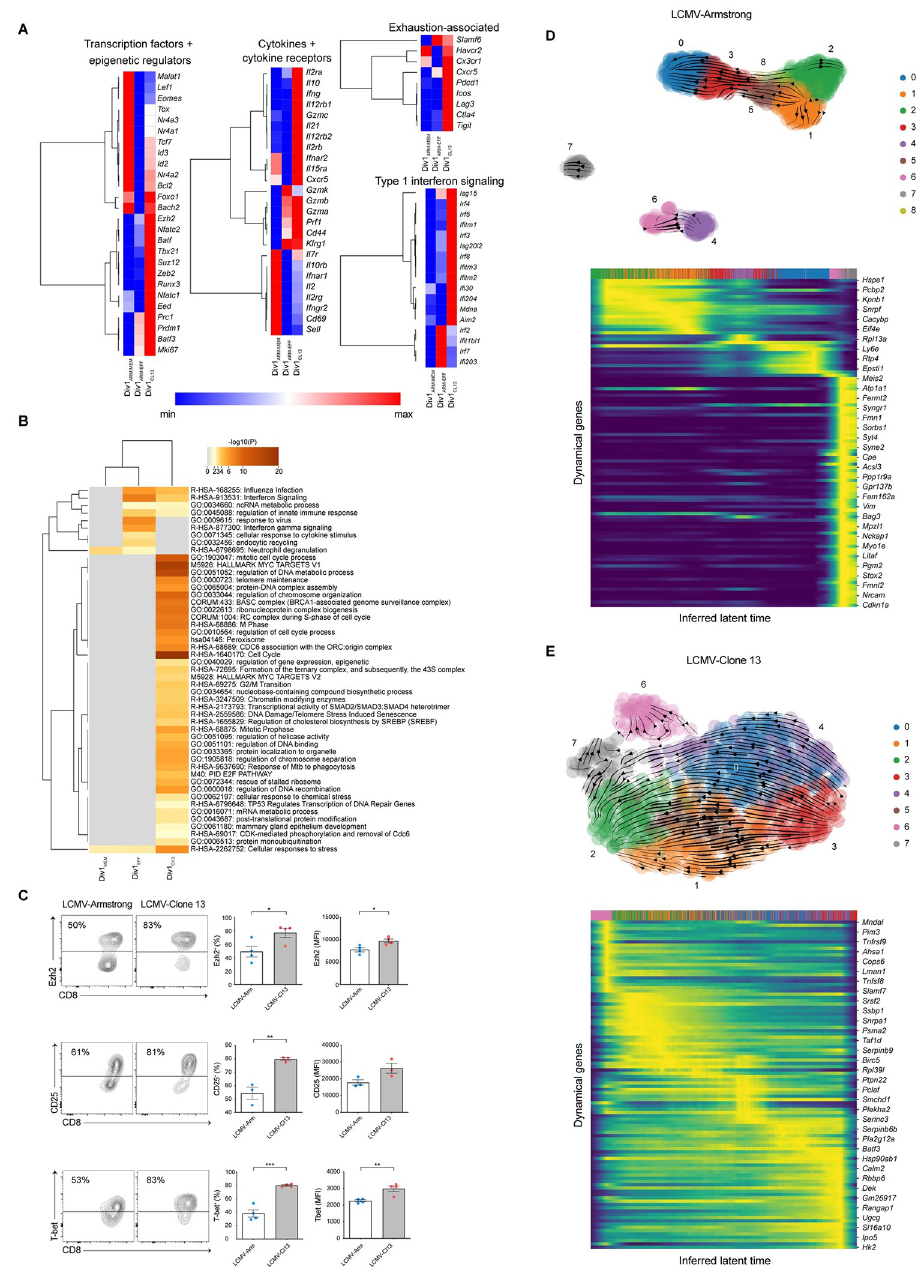
Fig 2. CD8 + T cells that have undergone their first division in response to LCMV-Arm vs. LCMV-Cl13 exhibit phenotypic and transcriptional heterogeneity. ( A ) Heatmaps representing relative gene expression of the three Division 1 clusters, Div1 ARM-EFF , Div1 ARM-MEM , and Div1 CL13 , divided by category; rows represent selected genes and columns represent each of three Division 1 clusters. ( B ) Enriched pathways among the three Division 1 clusters. ( C ) Representative flow cytometry plots (left) displaying expression of Ezh2, CD25 (IL-2R α ), and T-bet protein among gated Division 1 (second CFSE peak) P14 T cells. Bar graphs indicate the frequencies (middle) or MFI (right) of P14 T cells responding to LCMV-Arm (blue) or LCMV-Cl13 (red) expressing each molecule. Data are shown as mean ± SEM. ( D , E ) RNA velocities of Div1 ARM (D, top) or Div1 Cl13 (E, top) subclusters derived from scVelo projected onto a UMAP-based embedding. Putative driver genes derived from scVelo that may regulate the CD8 + Division 1 T cell response to LMCV-Arm (D, bottom) vs. LCMV-Cl13 (E, bottom), represented as heatmaps. Individual lines above each heatmap represent single cells; colors correspond to subcluster identities among Div1 ARM (D, top) or Div1 Cl13 (E, top) cells. � p < 0.05, �� p < 0.01, ��� p < 0.0001, ���� p < 0.0001 (Student’s t test). Data are representative of 2 to 3 independent experiments. The raw data for the panels in this figure are located in S1 Data file.